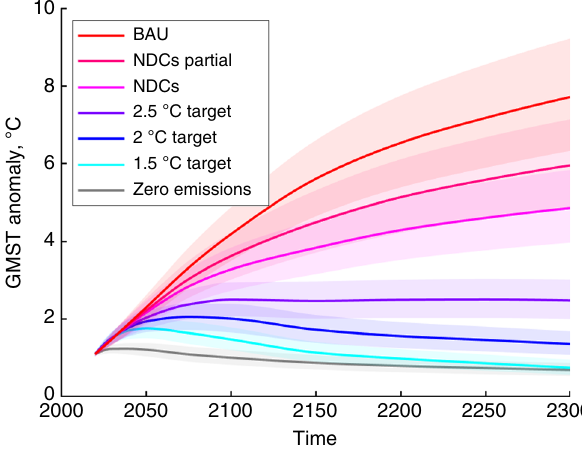
Fig. 3 Global mean temperature simulations under the range of climate scenarios considered. Median GMST projections relative to pre-industrial 1850 – 1900 levels (thick lines) and the relevant 25 – 75% ranges (shaded areas) obtained from 100,000 runs of PAGE-ICE for all the climate scenarios considered, assuming the following legacy values of the PCF and SAF: zero permafrost emissions, constant SAF of 0.35 ± 0.05 W m − 2 K − 1